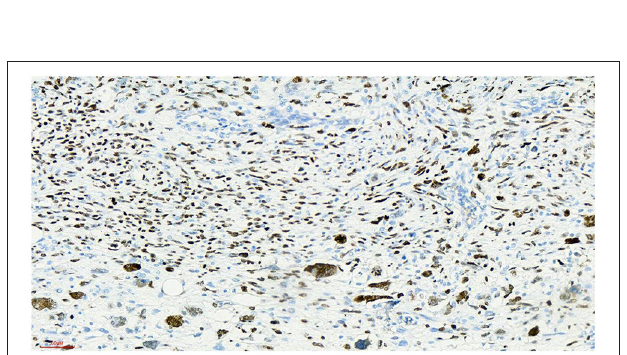
FIGURE 7 | Myod1 x 20, + , nucleoprotein staining showed diffuse expression of Myod1-positive tumor cells.